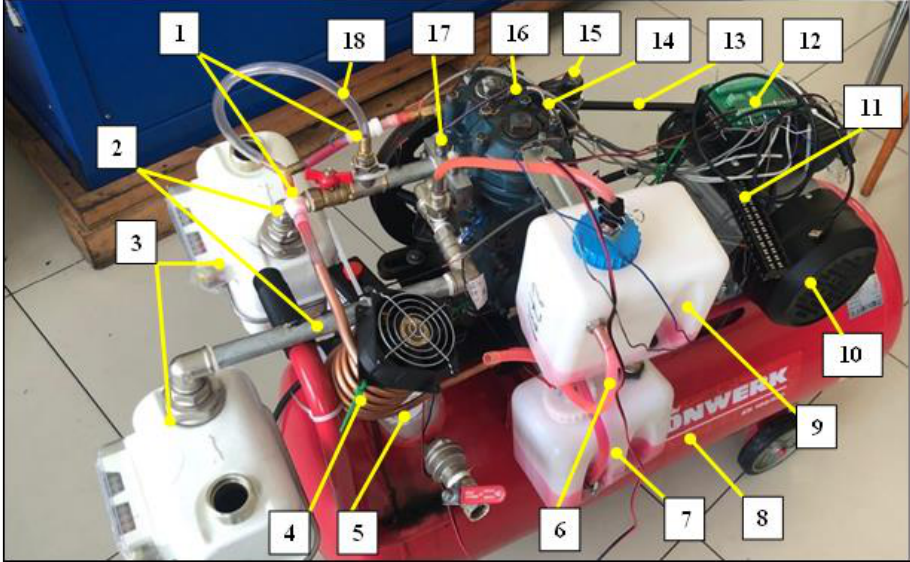
Figure 3. General view of the experimental stand: 1 — Check valves of the cooling system; 2 — Suction